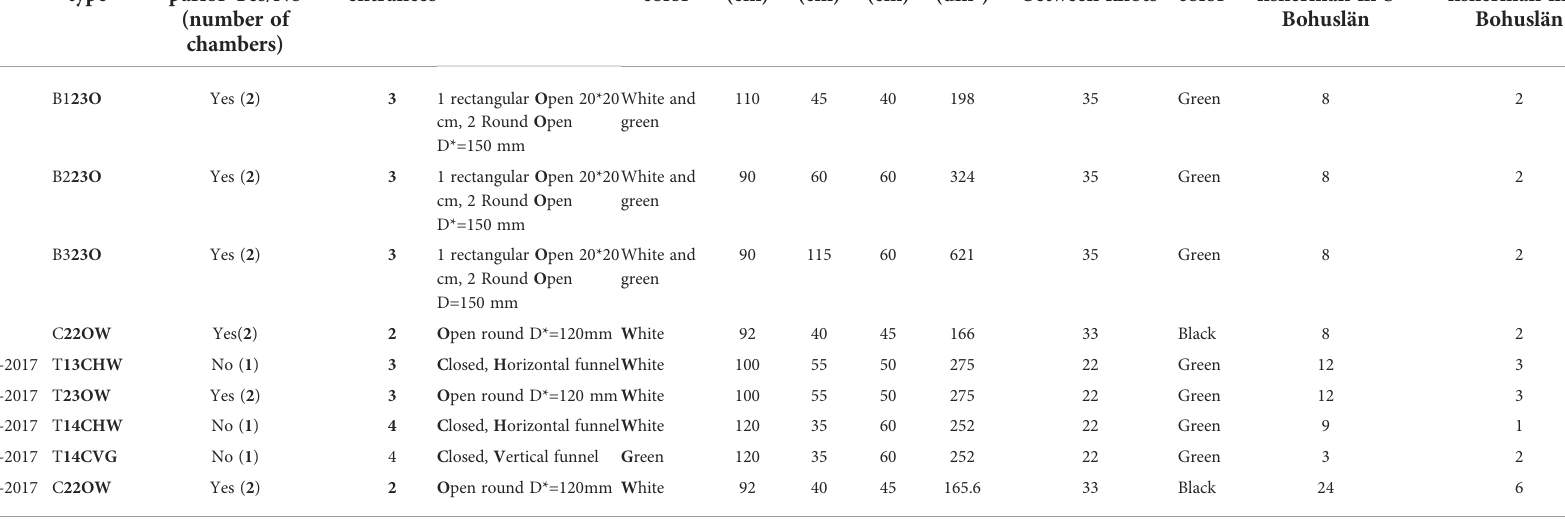
TABLE 1 The different characteristics of the pots evaluated in the study. Year Pot Is the pot equipped with type parlor Yes/No